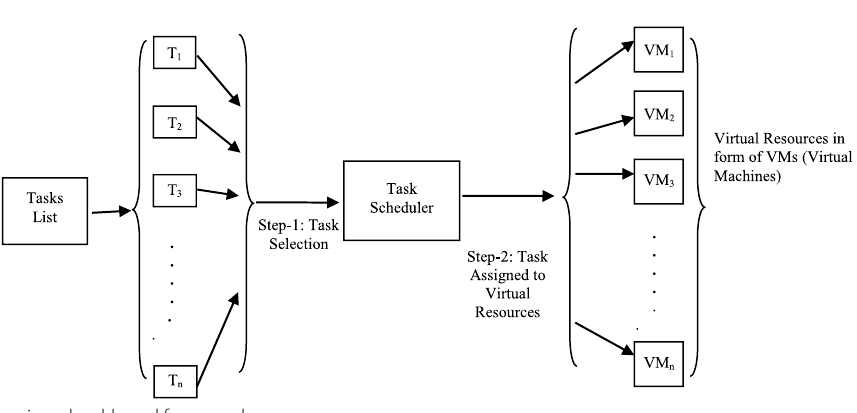
Fig. 2 Task scheduling in a cloud-based